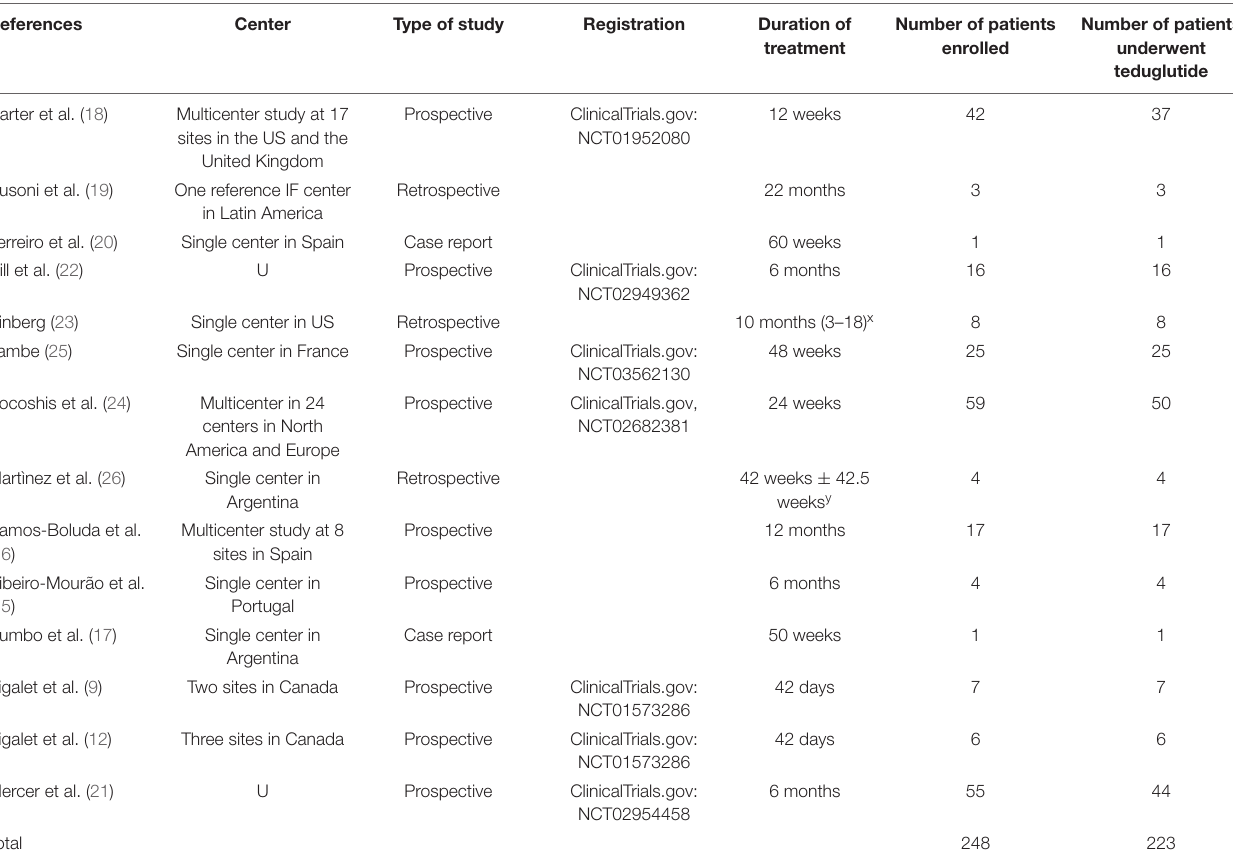
TABLE 1 | Characteristics of included